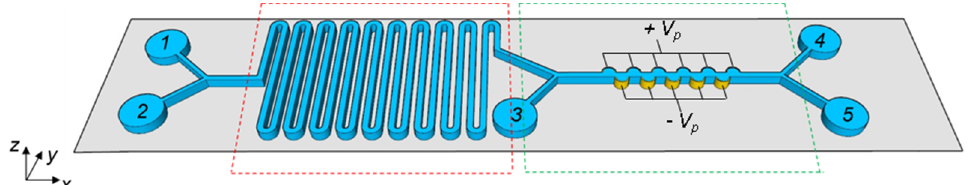
Figure 9. Proposed hybrid chip-scale platform formed by a micromixer channel (dotted red box) and